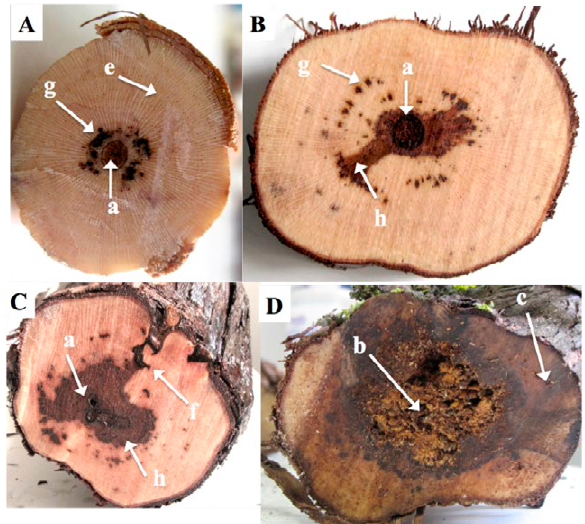
Figure 1. Cross-sections of grapevine trunks of different ages show- ing wood defects. (A) Early stages of wood infection, (B) and (C) advanced stages of infection, and (D) trunk affected by white rot. (a) Pith and holes, (b) decayed wood, (c) extended wood necrosis, (e) asymptomatic wood, (f) wood knots, (g) black spots, (h) central necrosis. Lower case letters represent some of the features identified in Table 1.